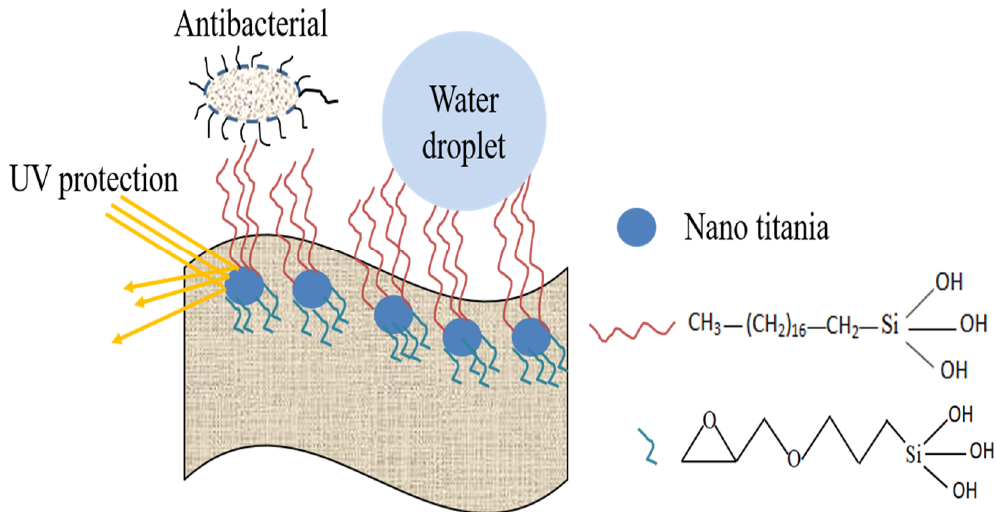
Figure 8. Fabric decorated with synthesized modified nano titania.